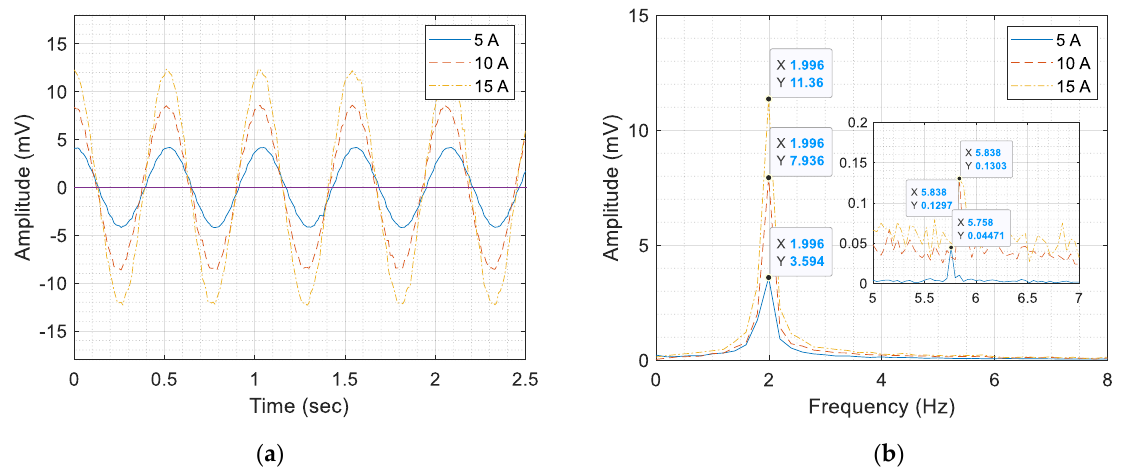
Figure 15. This figure shows the speed of the rotating coil 120 rpm (2 Hz): ( a ) the electromotive force of the magnetic field at 120 rpm; ( b ) the spectrum of the electromotive force of the magnetic field.